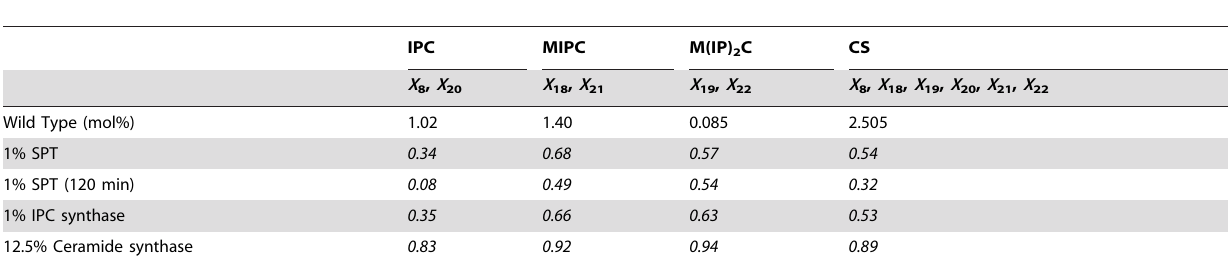
Table 3. Steady-state total mass of complex sphingolipid sub-populations in SL-E model under different experimental conditions, after 60